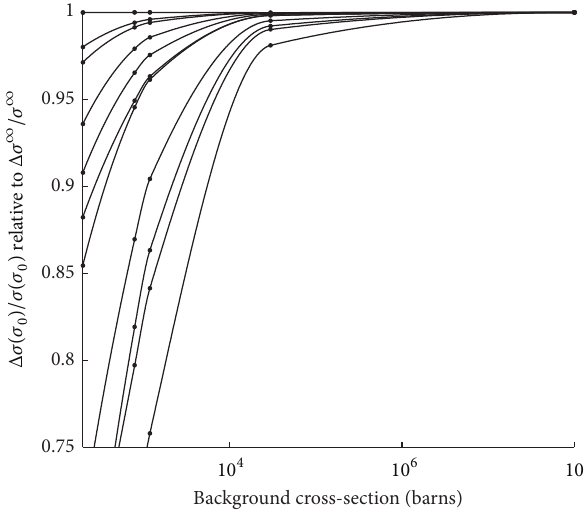
Figure 8: 𝜎 U 238 𝛾 covariance at 𝜎 0 = 2.0𝐸 + 4𝑏 .